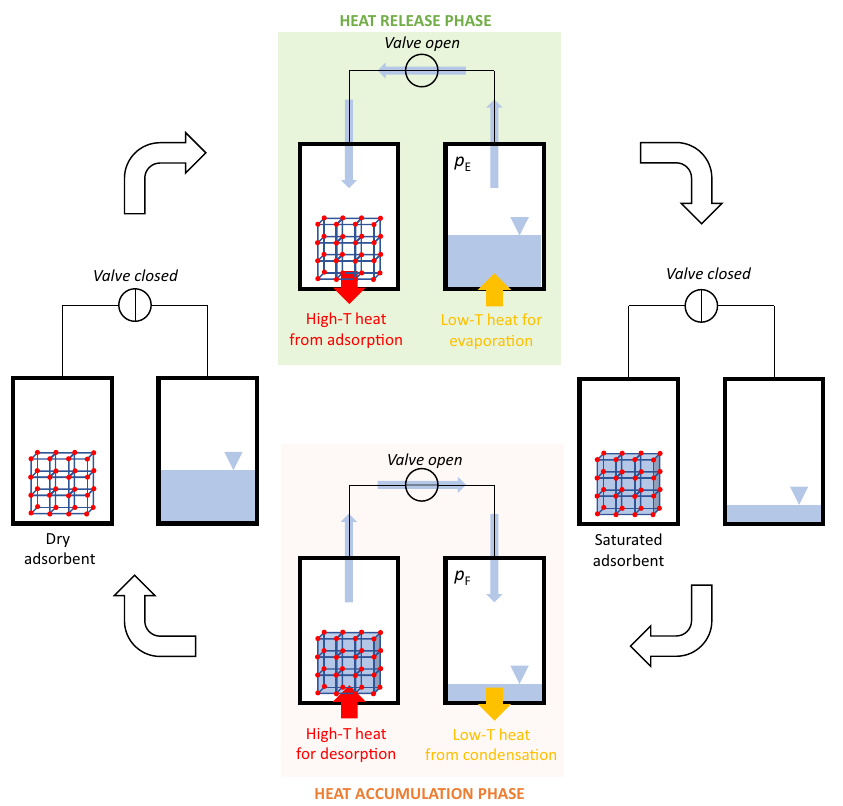
Fig. 9 Schematic of a closed water-sorption thermal energy storage system. The cycle underlying the heat accumulation and successive release is represented.